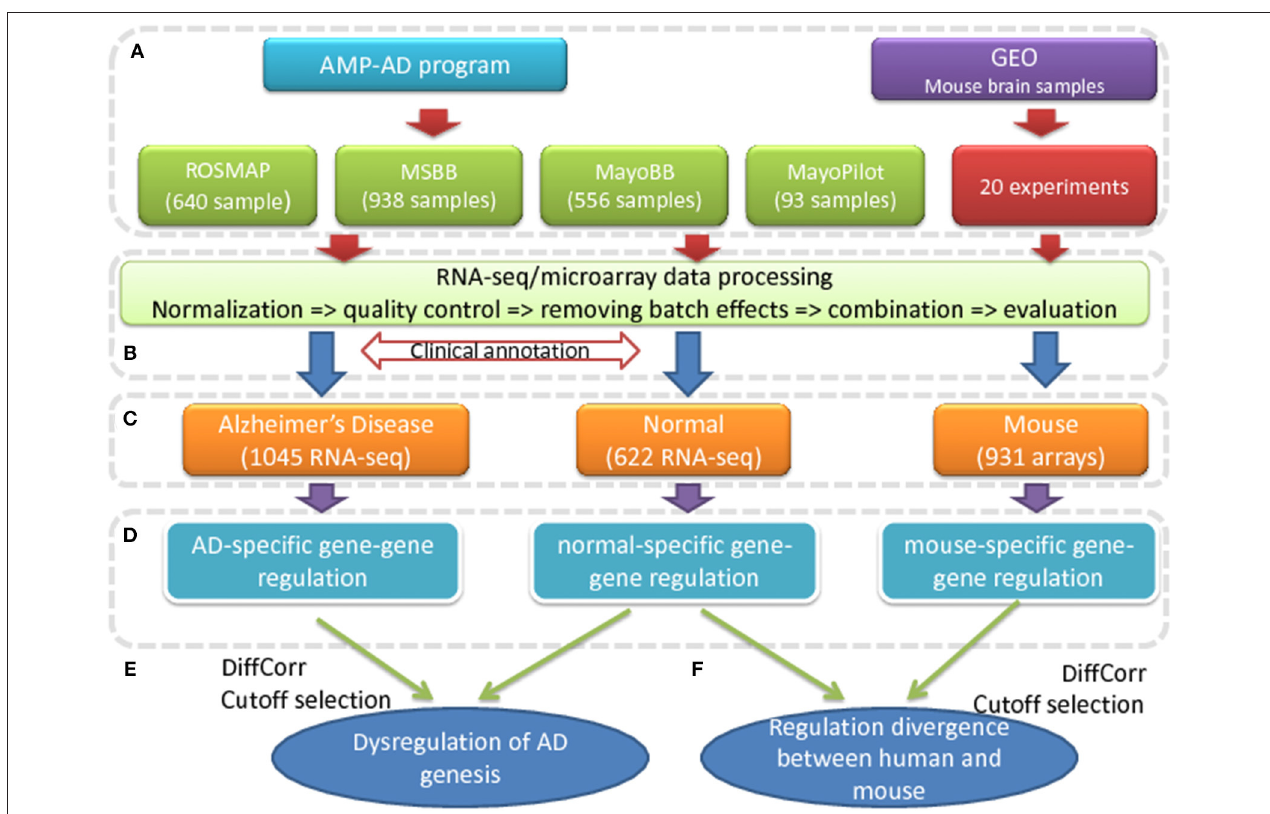
FIGURE 1 | The pipeline to find the transcriptional dysregulation in AD. (A) The human RNA-seq expression data are collected from four projects of AMP-AD program; the mouse brain expression data are collected from 20 microarray experiments in GEO database. (B) The expression data from different datasets are processed, normalized and combined to describe the expression profiles of AD patients, control subjects and mouse. (C) The human brain samples are categorized into AD patients and normal samples based on the clinical annotation. (D) All gene pairs are evaluated for gene-gene regulations by measuring co-expression correlations for all the gene pairs. (E) The dysregulated genes are predicted by differential co-expression analysis. (F) The co-expression conservation of all gene pairs are compared between human and